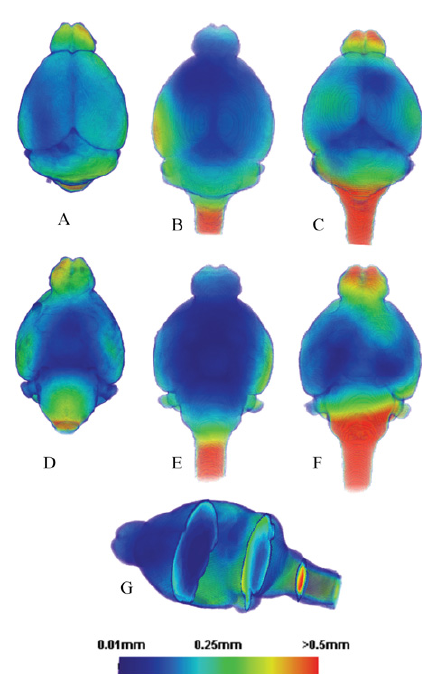
Figure 8. The average local deformation maps of: (A) 10 in vitro indi- vidual mouse brains mapped to the average in vitro brain. (B) 12 in vivo individual mouse brains mapped to the average in vivo brain. (C) 10 in vitro individual mouse brains mapped to the average in vivo brain. (D) , (E) and (F) : The ventral views of (A) , (B) and (C) , respectively. (G) A cross sectional view of (B) and (E) . Note: the images are not strictly proportional. The color repre- sents the average distance a given voxel underwent following registration of each of the individual brains to the average brain